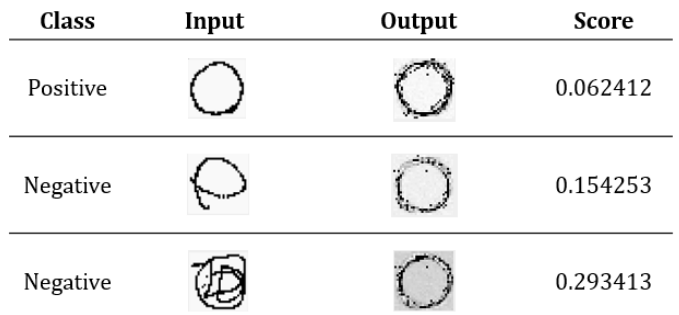
Figure 12. Different scores for different inputs.